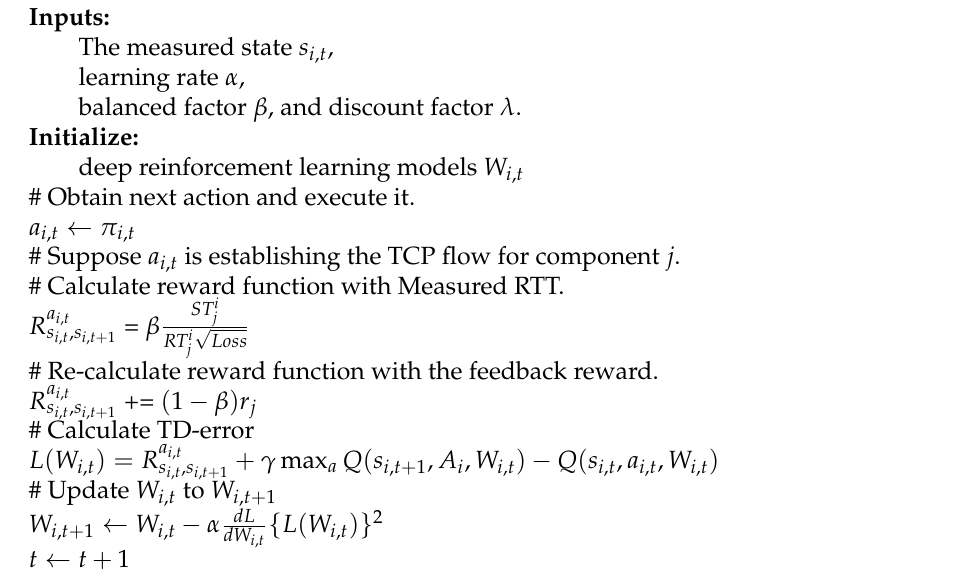
Algorithm 1 The hierarchical feedback learning control of network component i